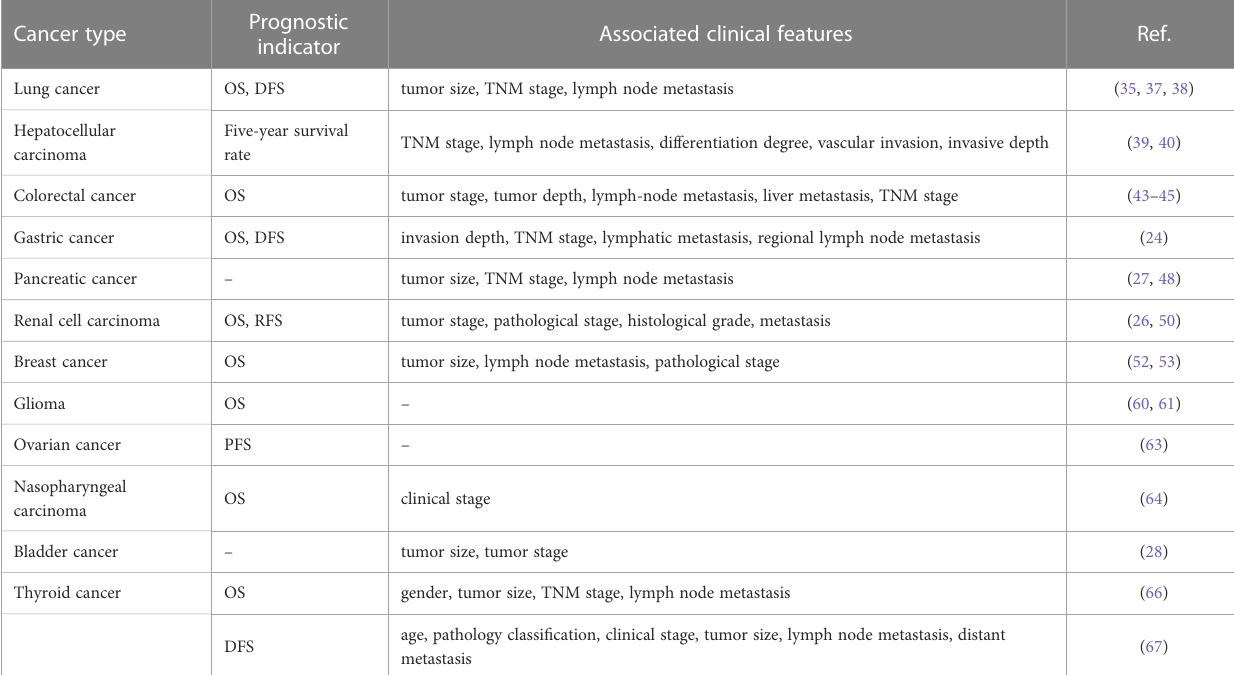
TABLE 3 Involvement of SNHG15 in cancer